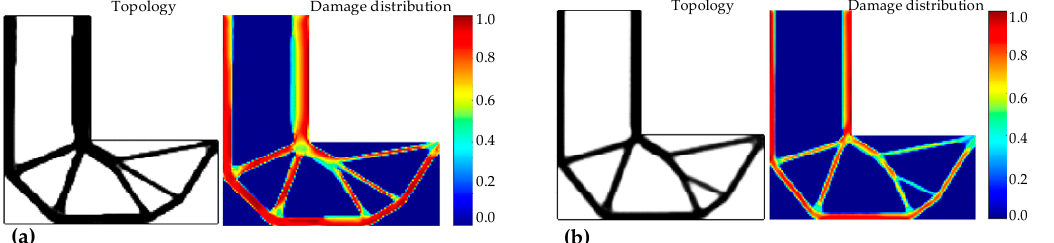
Figure 7. Optimal topology and damage distribution for an L-bracket subjected to a single load: ( a ) P-norm constraint ( f = 0.305), ( b ) local constraint ( f = 0.240).